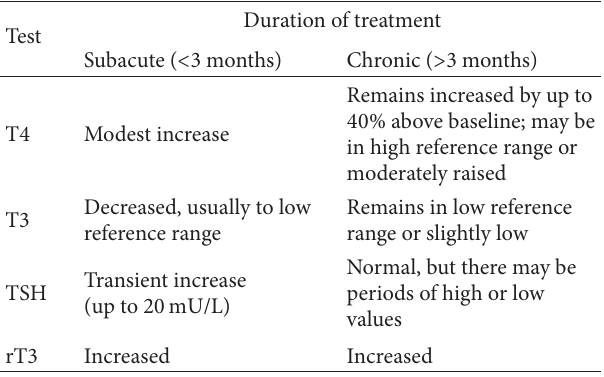
Table1:Effectsofamiodaroneonthyroidfunctiontestsineuthyroid patients.